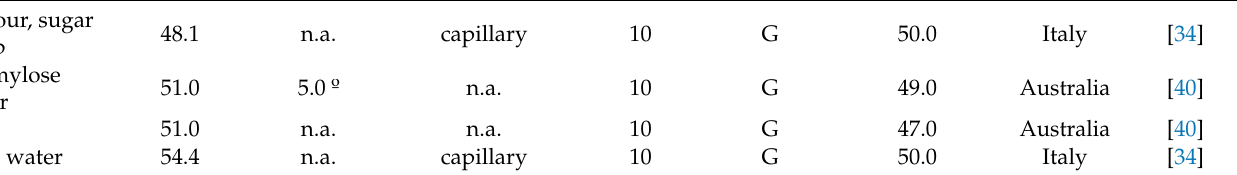
Table 1. Pasta product characteristics, glycemic index and experimental protocol